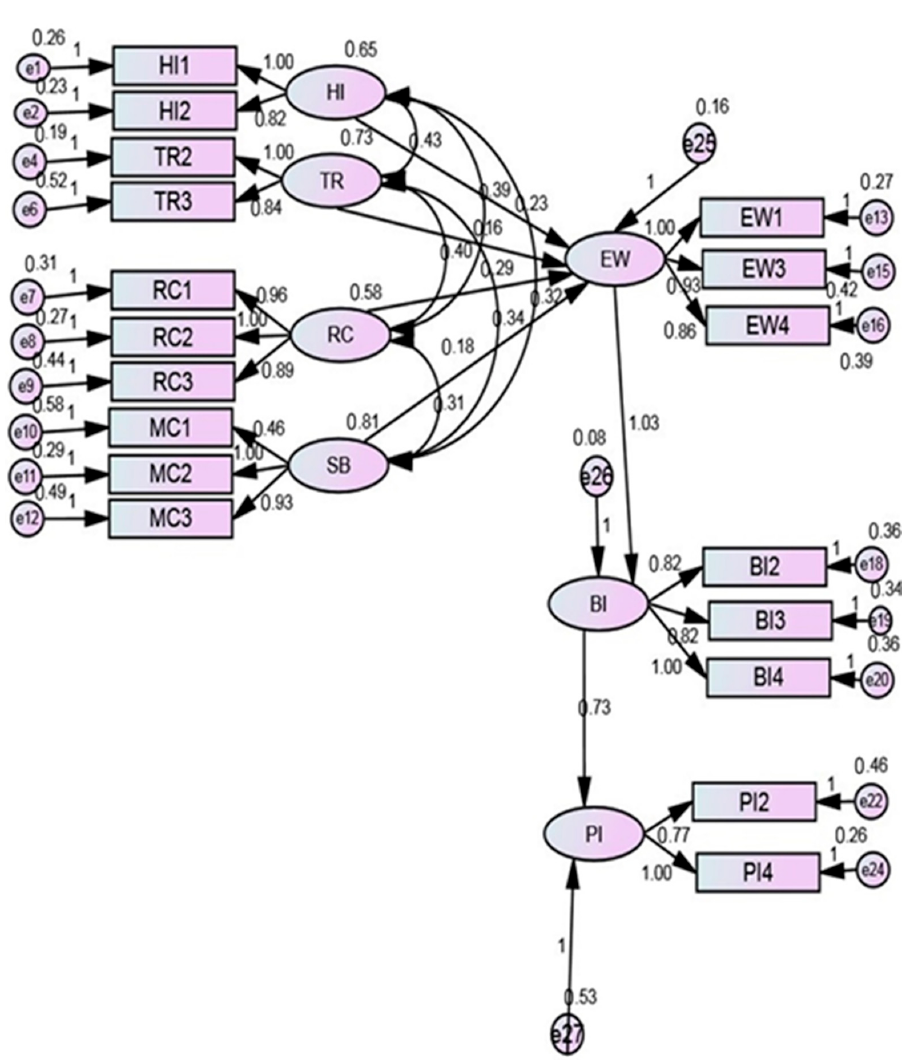
Figure 3. Structural model of the study.